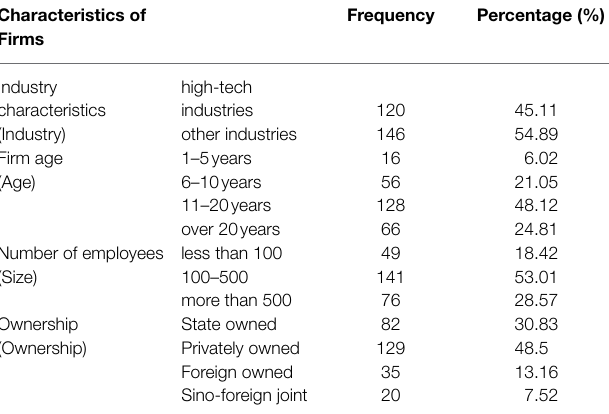
TABLE 1 | Profile of sampled